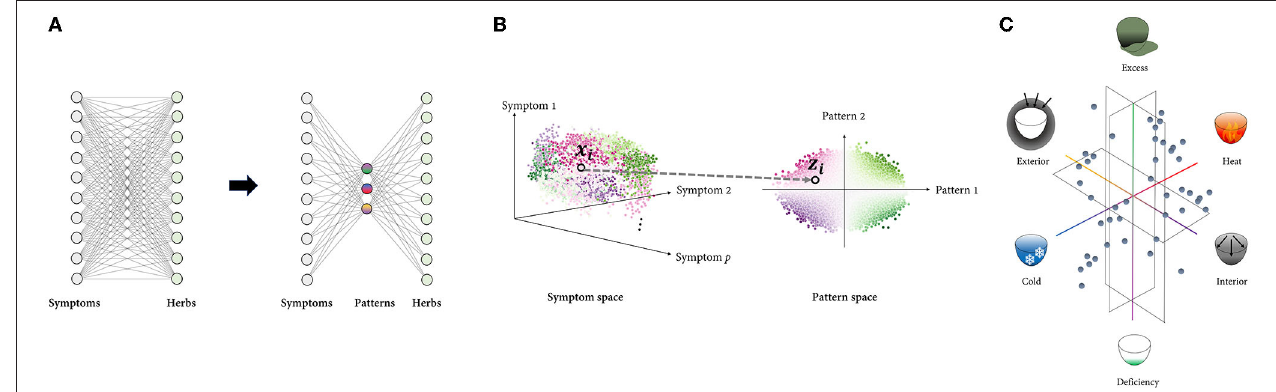
FIGURE 2 | Framework modeling the PI with dimensionality reduction. (A) : Rather than mapping high-dimensional spaces directly, the number of cases can be reduced exponentially by first projecting the input space to low-dimensional space composed of multiple latent variables and then mapping it to the output space. (B) : Representing the data using a few underlying patterns reveals the intrinsic structure of the data, which is difficult to capture in a high-dimensional space where distinct factors of variations are highly entangled. Each point represents sample data, and the points denoted by a black circle represent the ith sample, which is represented in both the symptom space ( x i ∈ R p ) and the pattern space ( z i ∈ R r ). The points are color-coded according to the identified patterns. (C) : TAM’s low-dimensional pattern space is constructed from metaphorical concepts that are embodied in everyday life. The pattern space in eight-principle PI, the most comprehensive type of PI, is visualized as an example. Six of eight principle patterns are composed of the exterior, interior, cold, heat, deficiency, and excess, while the other two are Yin and Yang, which are higher concepts that encompass the other six patterns. Six principle patterns are grouped in pairs of mutually opposing properties: exterior-interior, cold-heat, and deficiency and excess. These three pairs represent the extent to which external pathogens penetrate the body, the nature of the disease, and the relative superiority of the body’s resistance to pathogenic factors and the pathogenic qi, respectively. These concepts’ familiar and abstract characteristics enable robust inference of the pathological pattern from a myriad of symptom